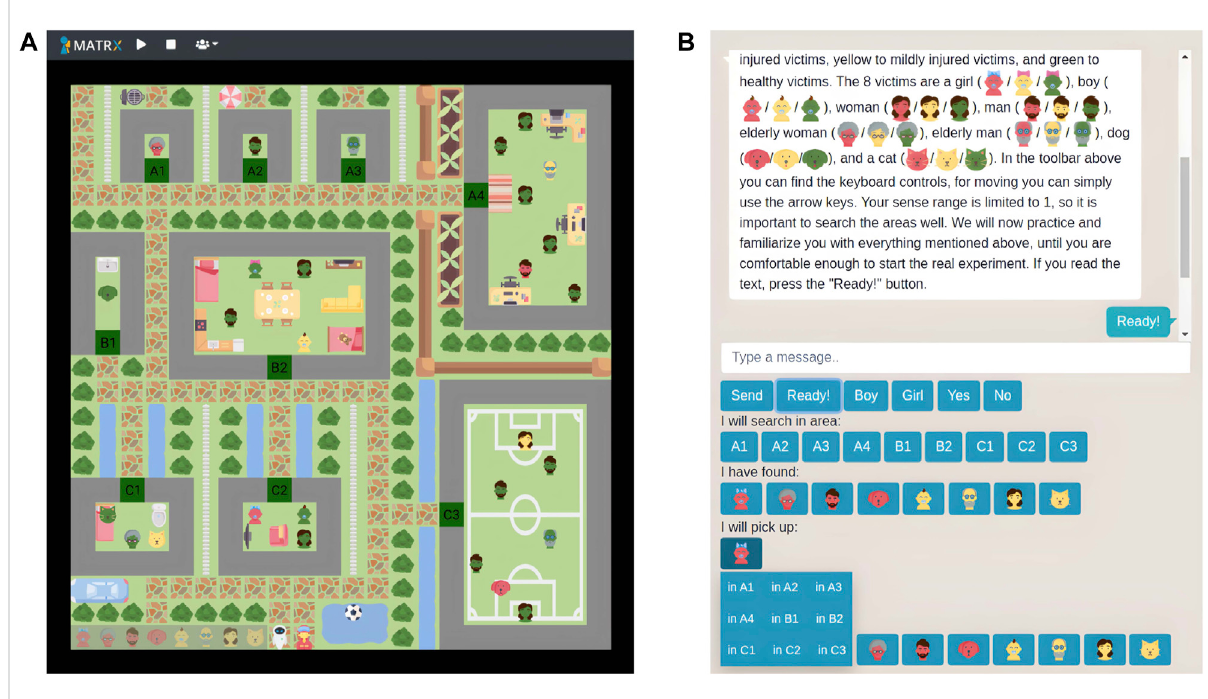
FIGURE 1 (A) God view of the MATRX world used for this study. The lower left corner of the world shows the drop zone with eight victims to search and rescue. Next to the drop zone are RescueBot and the human avatar at their starting positions. (B) the chat functionality and buttons used by participantstocommunicate.Inaddition,thedifferentvictimandinjurytypescanbeseen.Buttonsexistedforeachareaandgoalvictimtosearchand